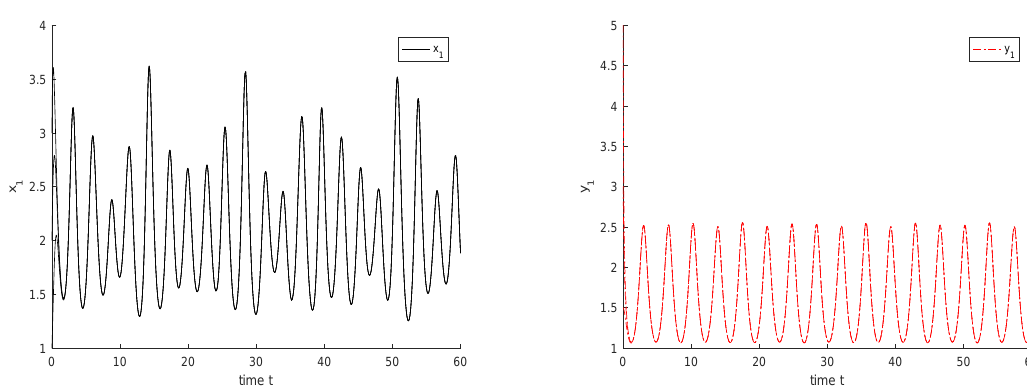
(0)) = (1, 1.5), (0), y * 1 1